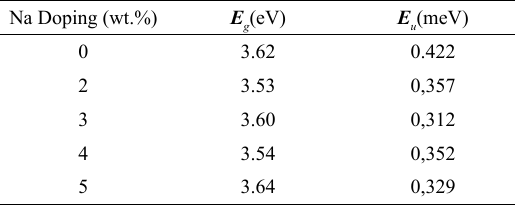
Table 2. The variation of band gap energy E E of Na doped NiO thin films as a function of doping level. u Na Doping (wt.%)